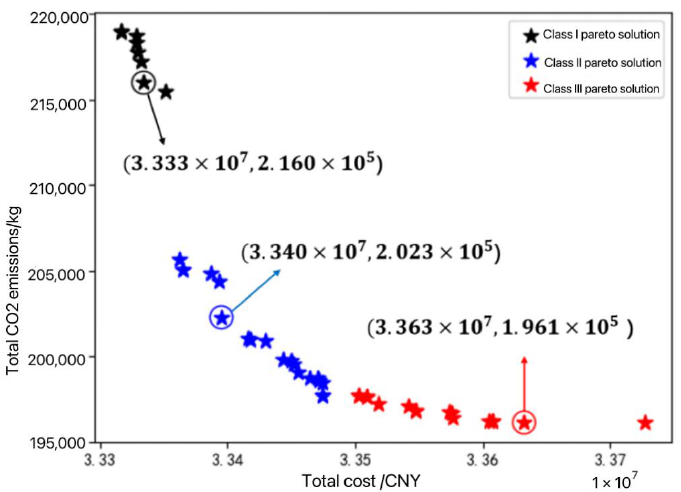
Figure 17. Schematic diagram of sample solution selection for the Pareto solution of total cost and total carbon dioxide emissions (M = 3000).